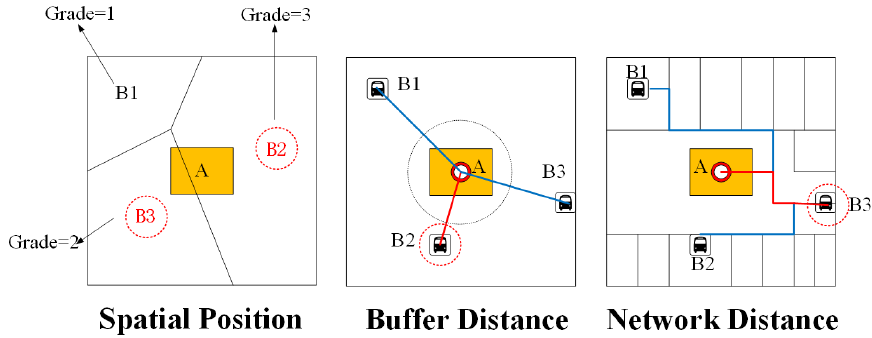
Figure 5. GIS-based Quantitative measures.